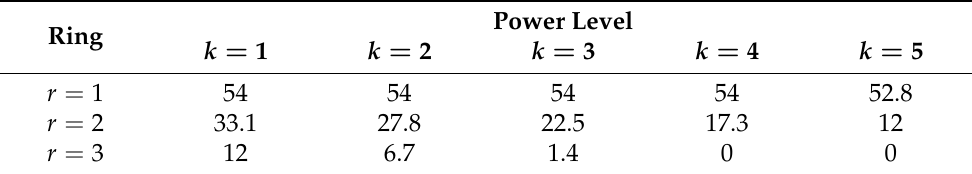
Table 6. Quantised rates (in Mbps) for the reduced model energy (RME) model.